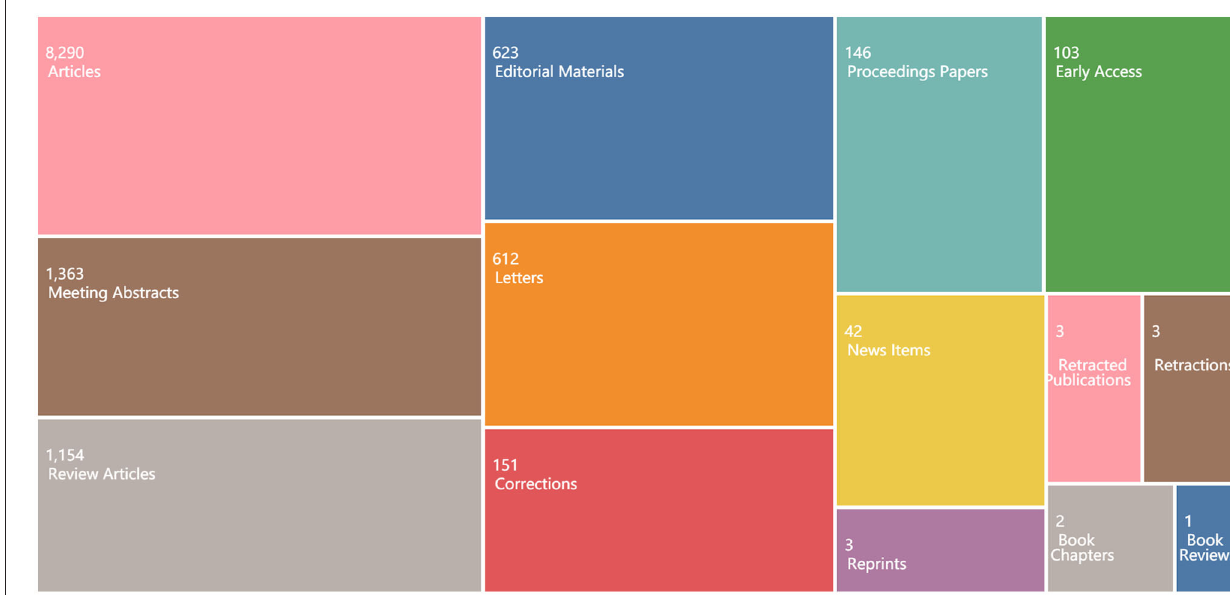
FIGURE 2 | Treemap chart of document types.